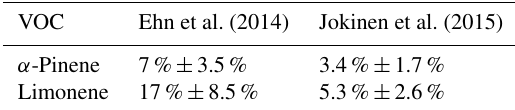
Table 2. ELVOC yields and